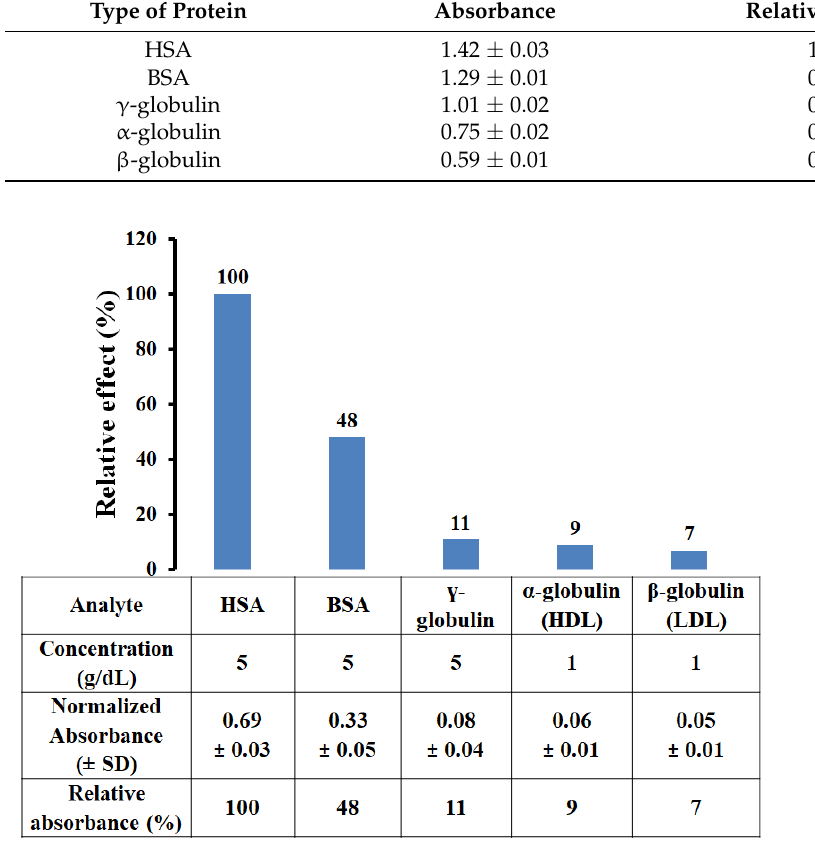
Figure 9. Selectivity of HSA-MIP-based microplate assay in the presence of various suspected interferences.